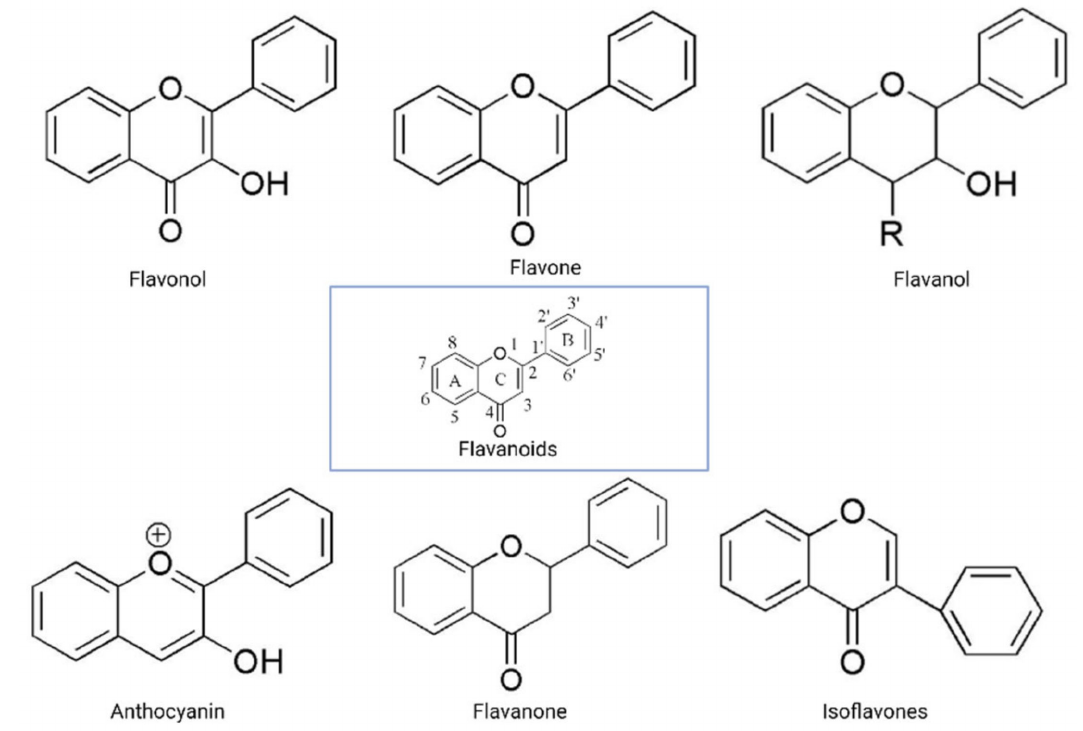
Figure 1. General structure of flavonoids. Adapted from Wang et.al.